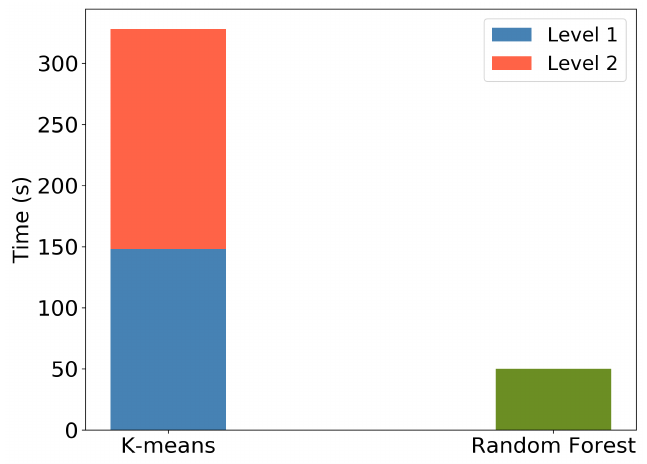
Figure 20. Computation time of k-means, showing Level 1—land vs. water clustering—and Level 2— for k = 7 on the land cluster. Computation time of RF in Cheorwon site with depth = 50 and trees =